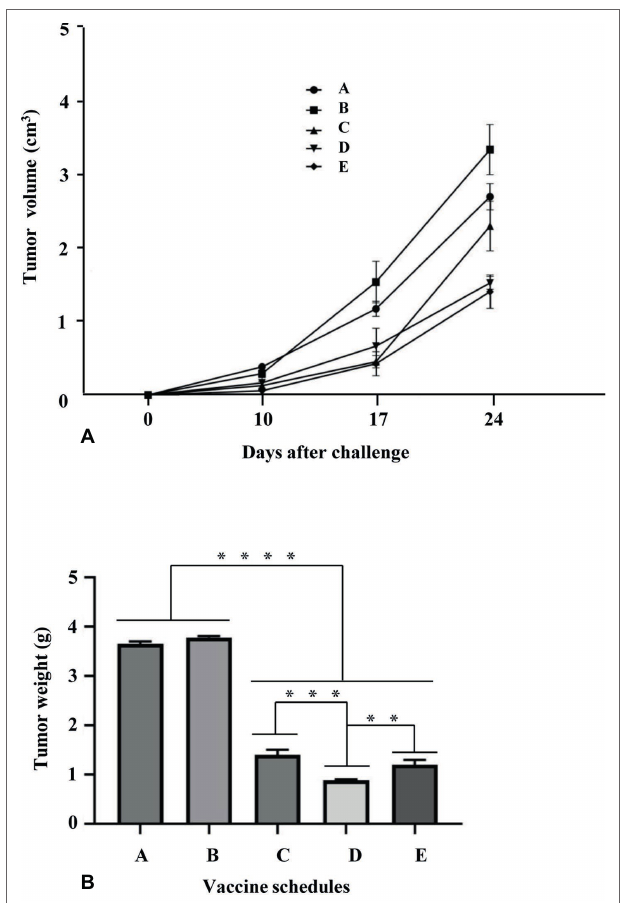
FIGURE 8 | Anticancer activity His 6 -E7*-SAPKQ in TC-1 mouse model. C57BL/6 mice were challenged with 5 × 10 4 TC-1 cells and thereafter treated with the different vaccine preparations as in Materials and Methods. Schedules of vaccination were as follows: A, empty pVax prime/mock hairy root extract boost; B, mock hairy root extract prime/mock hairy root extract boost; C, pVax-E7*-SAPKQ prime/pVax-E7*-SAPKQ boost; D, pVax-E7*- SAPKQ prime/E7*-SAPKQ extract boost; E, SAPKQ extract prime/SAPKQ extract boost. (A) Tumor volumes were recorded at different intervals after boost as in Materials and methods. Data represent means of five animals ± SEM. (B) Tumor weights were recorded when tumor controls reached >3 cm 3 and all animals were euthanatized for ethical reasons. Data are means of five animals ± SD. **** p < 0.0001; *** p < 0.001; ** p <